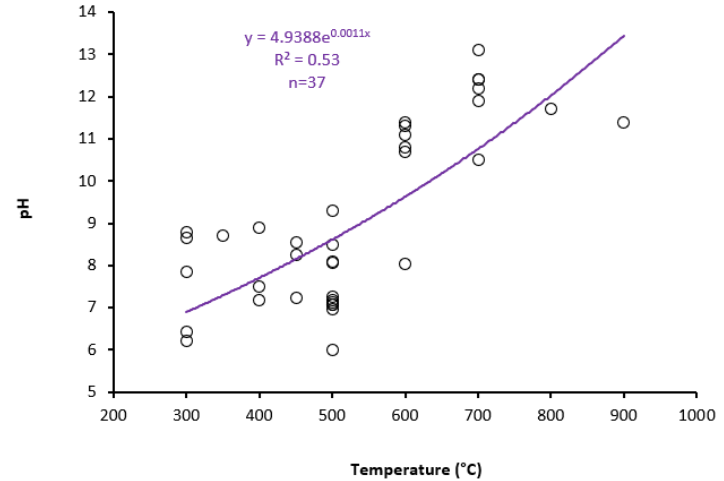
Figure 2. Regression relationships between pH and pyrolysis temperature.